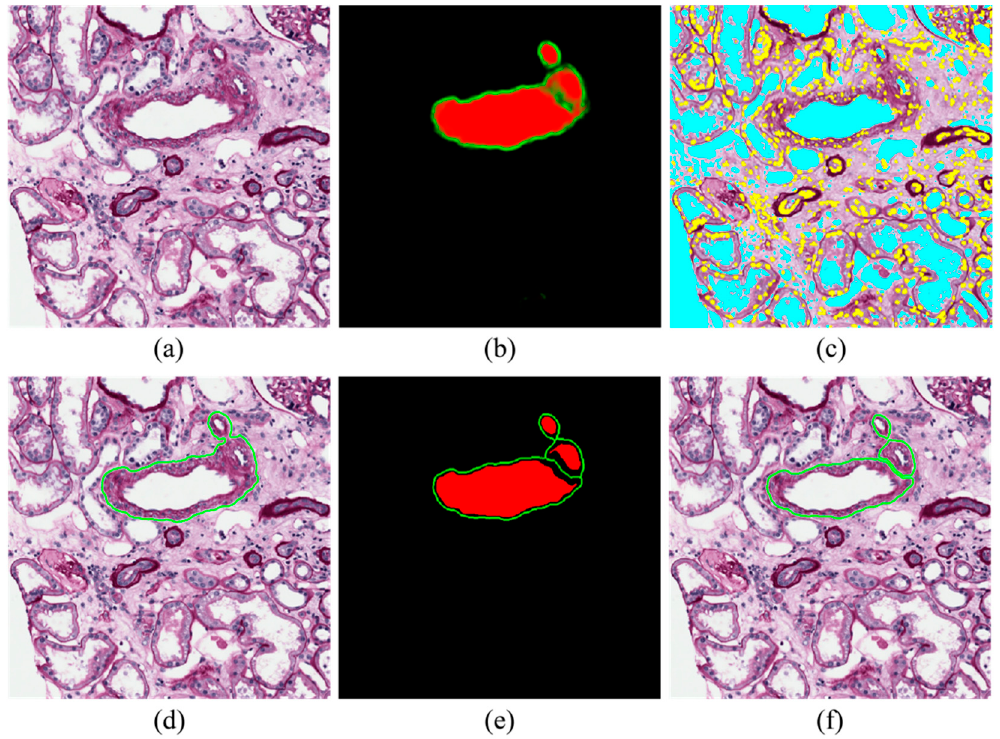
Figure 5. Steps performed by RENFAST for blood vessel detection. ( a ) Normalized image; ( b ) CNN probability map; ( c ) Cellular structure detection (yellow: nuclei, cyan: lumen); ( d ) Initial blood vessel segmentation; ( e ) Softmax with high SNR (signal-to-noise ratio); ( f ) Final blood vessel segmentation.